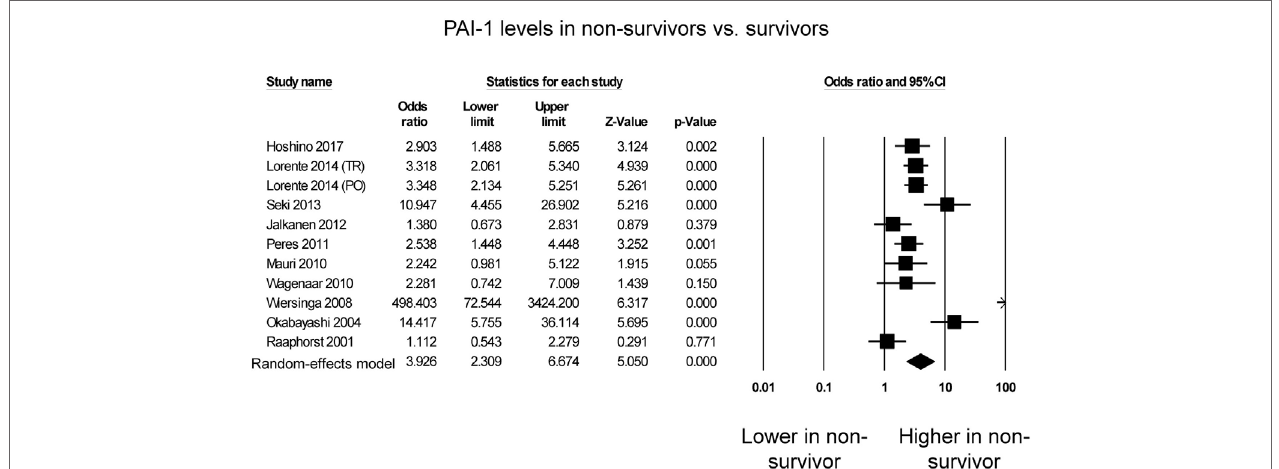
FigURe 2 | Forest plot comparing plasminogen activator inhibitor-1 (PAI-1) levels between non-survivors and survivors of